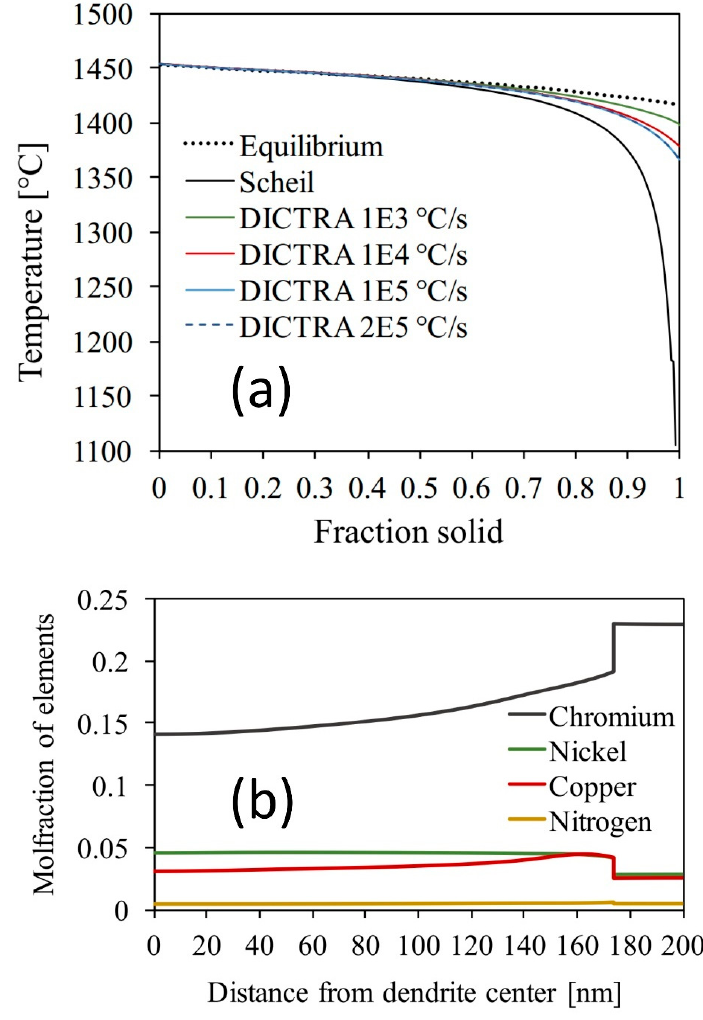
Figure 9. ( a ) Temperature-dependent solidification profile for reduced composition of 17-4 using equilibrium solidification, Scheil solidification, and DICTRA at different cooling rates. ( b ): elemental distribution across dendritic arm spacing predicted by DICTRA at a cooling rate of 1 × 10 5 °C/s.